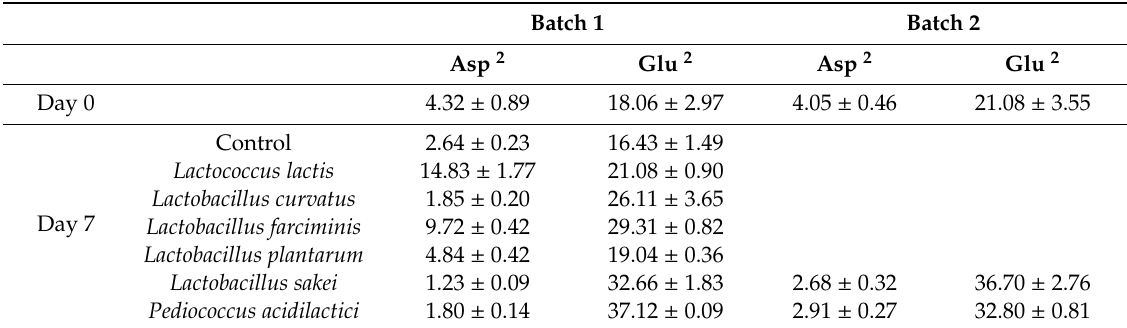
Table A2. (Supporting Information) . Changes in the contents of the free amino acids aspartic acid (Asp) and glutamic acid (Glu) during fermentation of a mealworm paste with the addition of the curing agent sodium nitrite 1